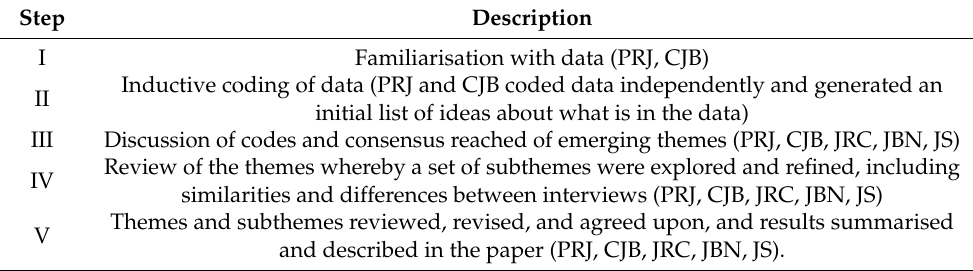
Table 1. Thematic analysis.